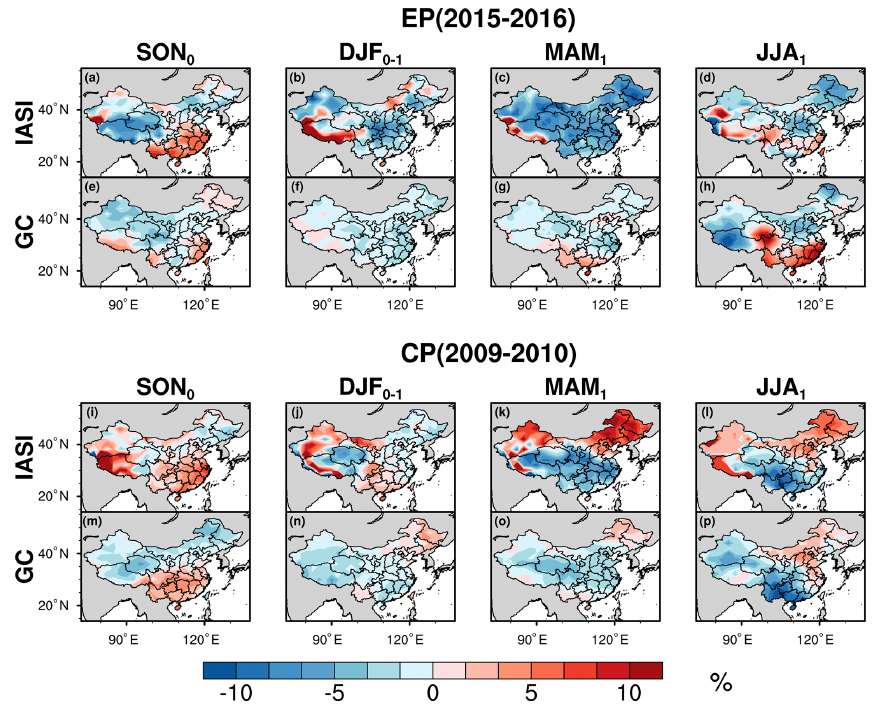
Figure 1. The changes (in %) relative to climatology state (September 2007–August 2017) of satellite-observed (IASI) and model-simulated (GC) tropospheric column ozone (0–6km; in DU) for the four seasons in EP (2015–2016) and CP (2009–2010) El Niño